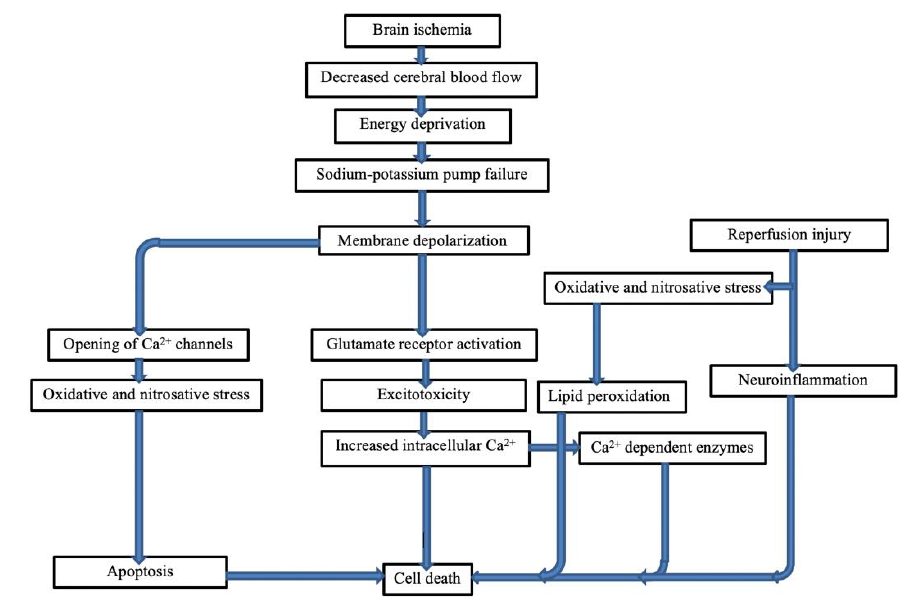
Figure 2. Ischemic stroke pathogenesis and possible targets of neuroprotection.